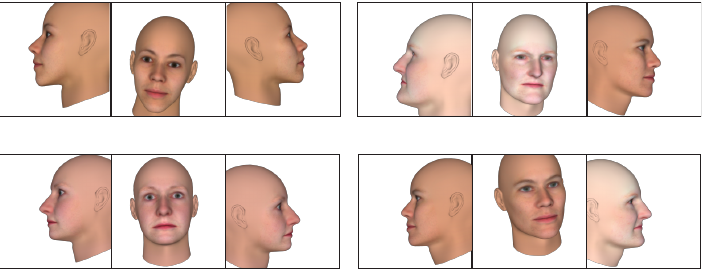
Figure 7. Example renderings of FaceGen faces rendered with the pose angles described in Figure